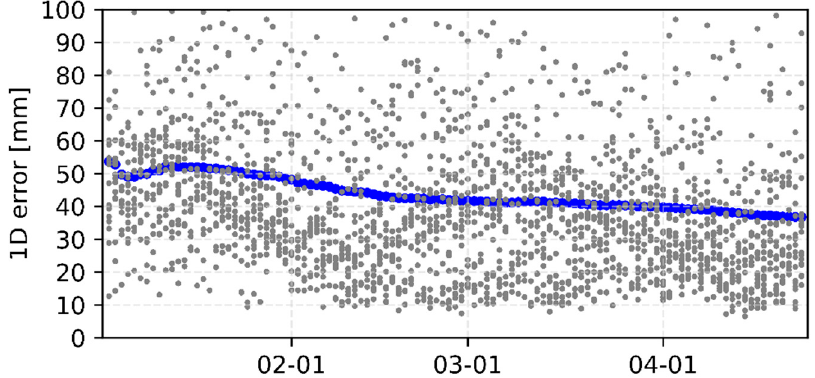
Figure 9. Consistency between iGMAS and IGS final combined GLONASS orbits. The gray circles indicate each GLONASS satellite for individual day and the blue circles represent the median RMS of all satellites.